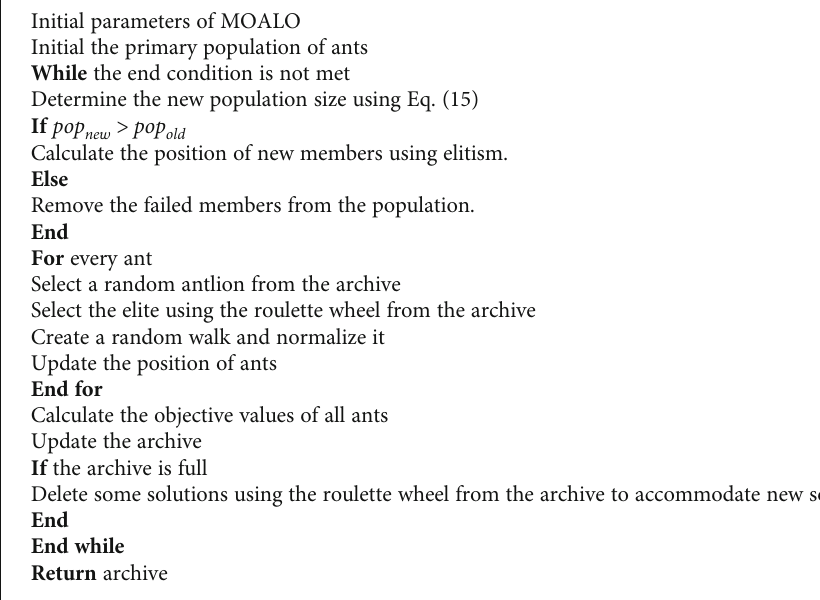
Algorithm 1: The improved MOALO.